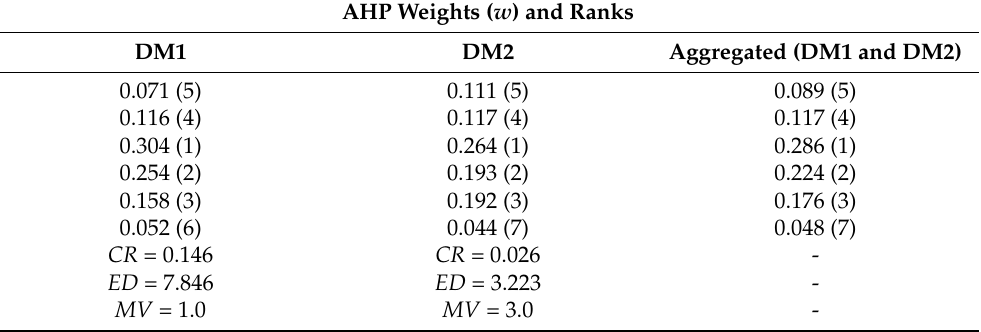
Table 8. AHP criteria weights obtained by eigenvector method and aggregated by Formula (14) and consistency